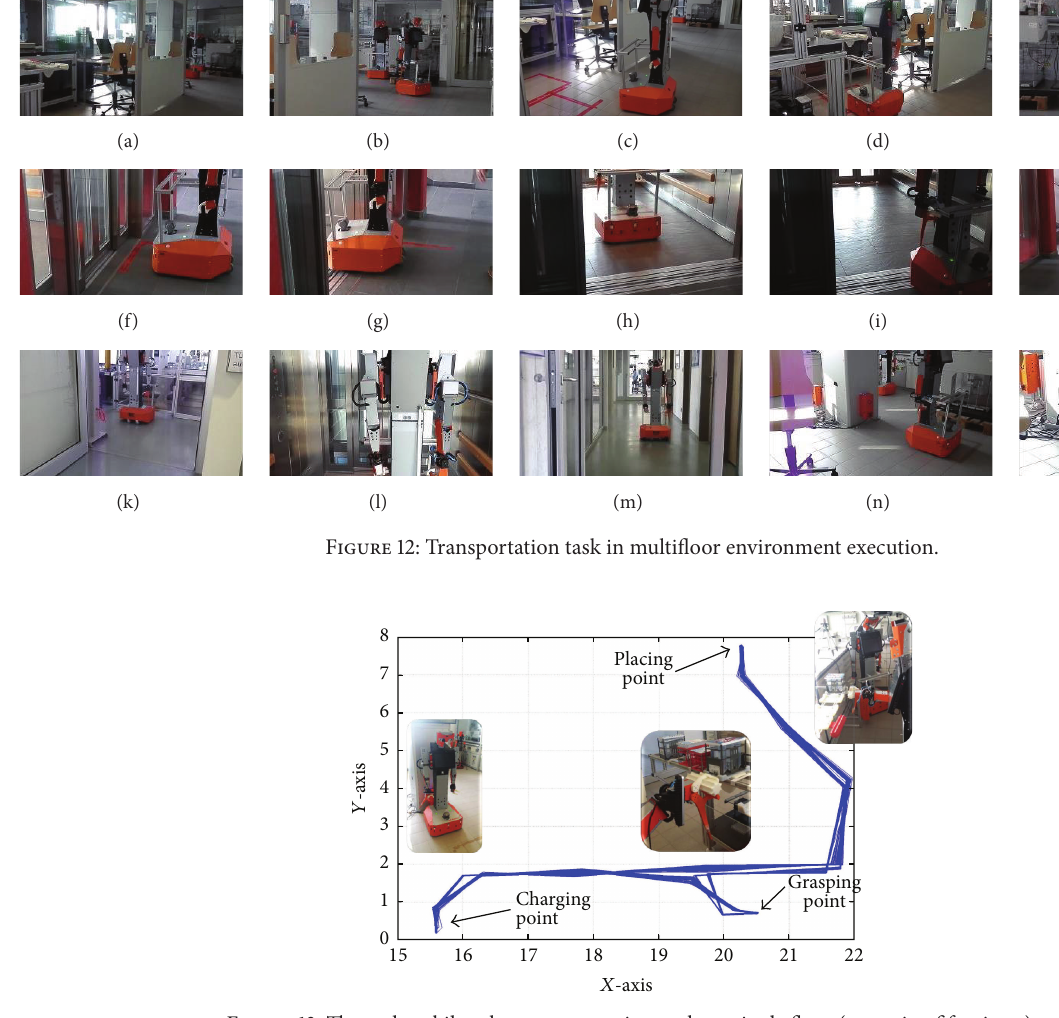
Figure 13: The real mobile robot transportation path on single floor (repeating fifty times).